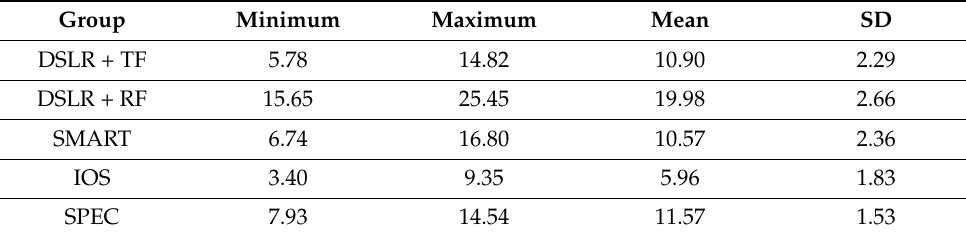
Table 4. The distribution of the color difference ( ∆ E).